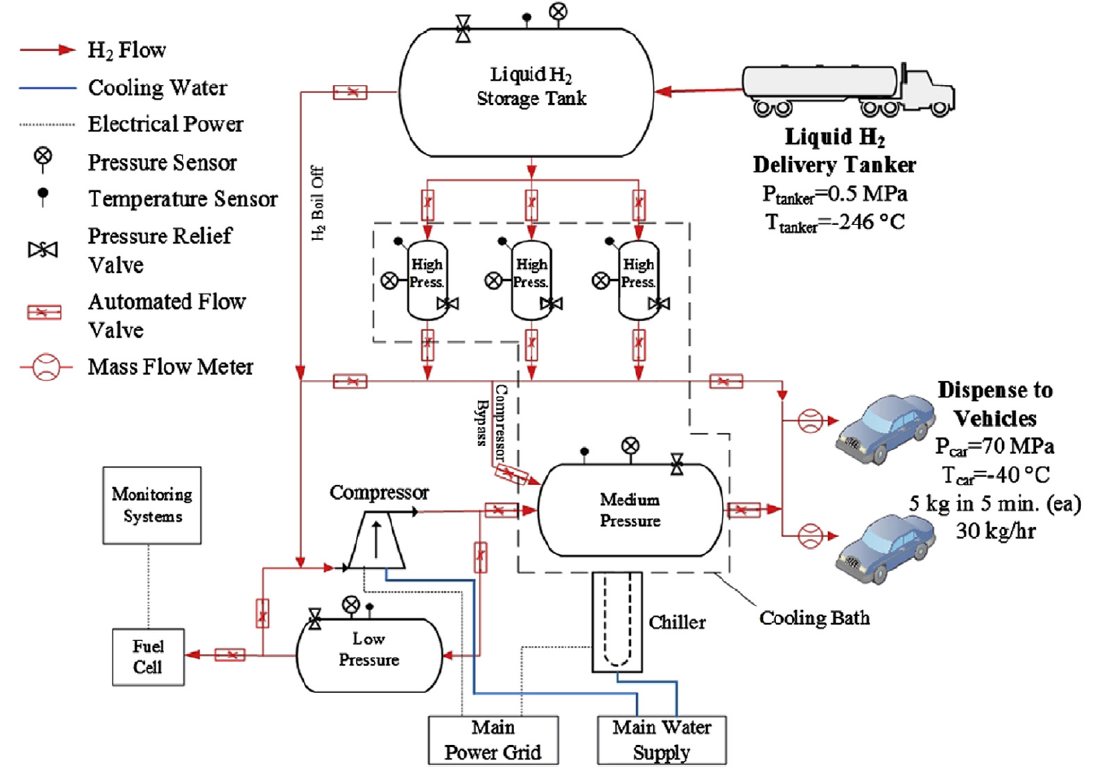
Figure 7. The design of a transportable vehicle fueling station [80].